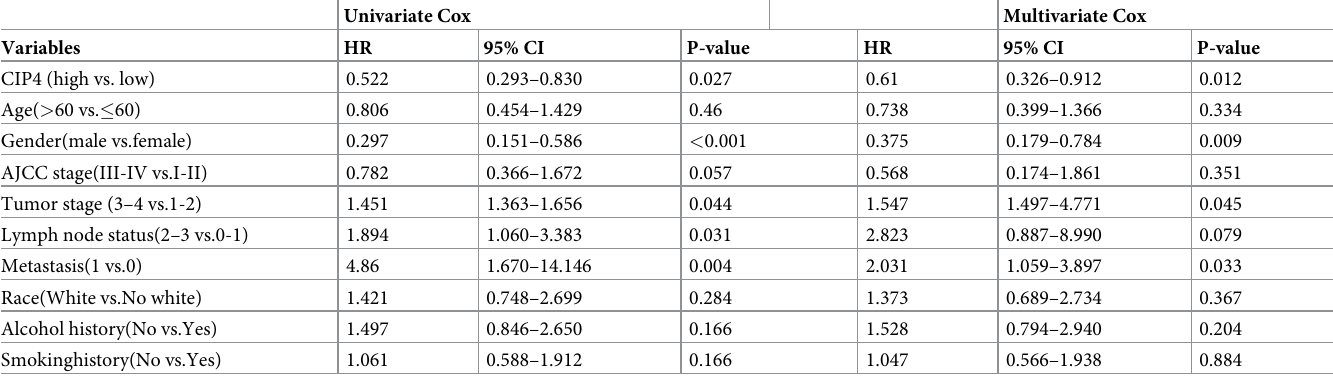
Table 2. Univariate and multivariable cox regression analysis on OS. Univariate Cox Multivariate